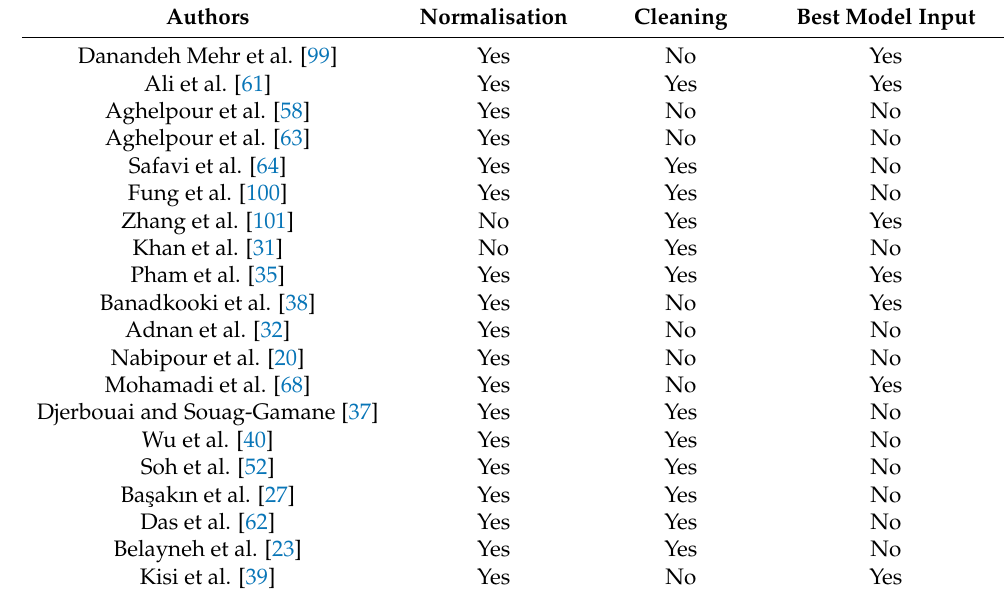
Table 7. Summary of data